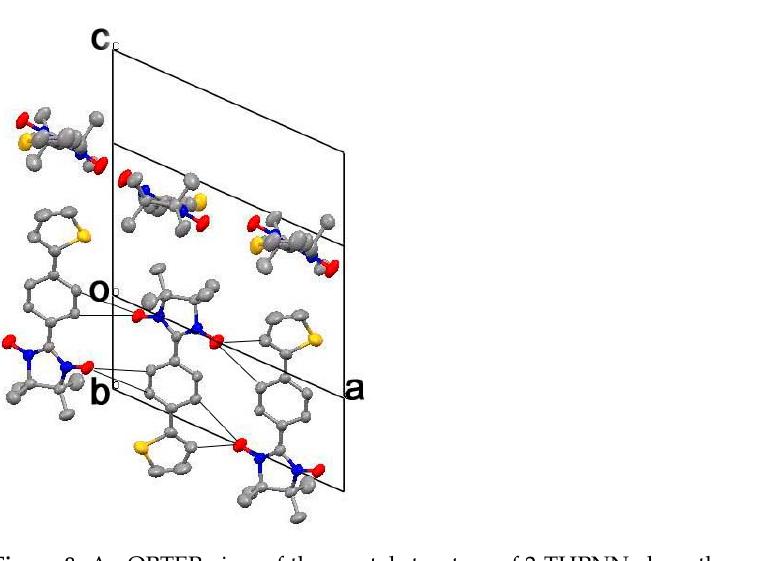
Figure 8. An ORTEP view of the crystal structure of 2-THPNN along the vertical direction to the molecular planes. The 2-THPNN molecules form side-by-side molecular stacks along the a axis in a head-to-tail manner.